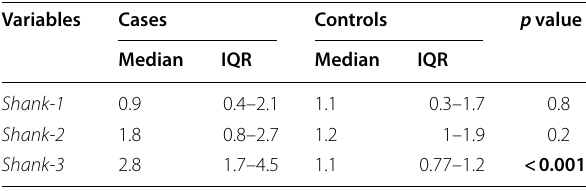
Table 3 Expression of SHANK family genes among studied